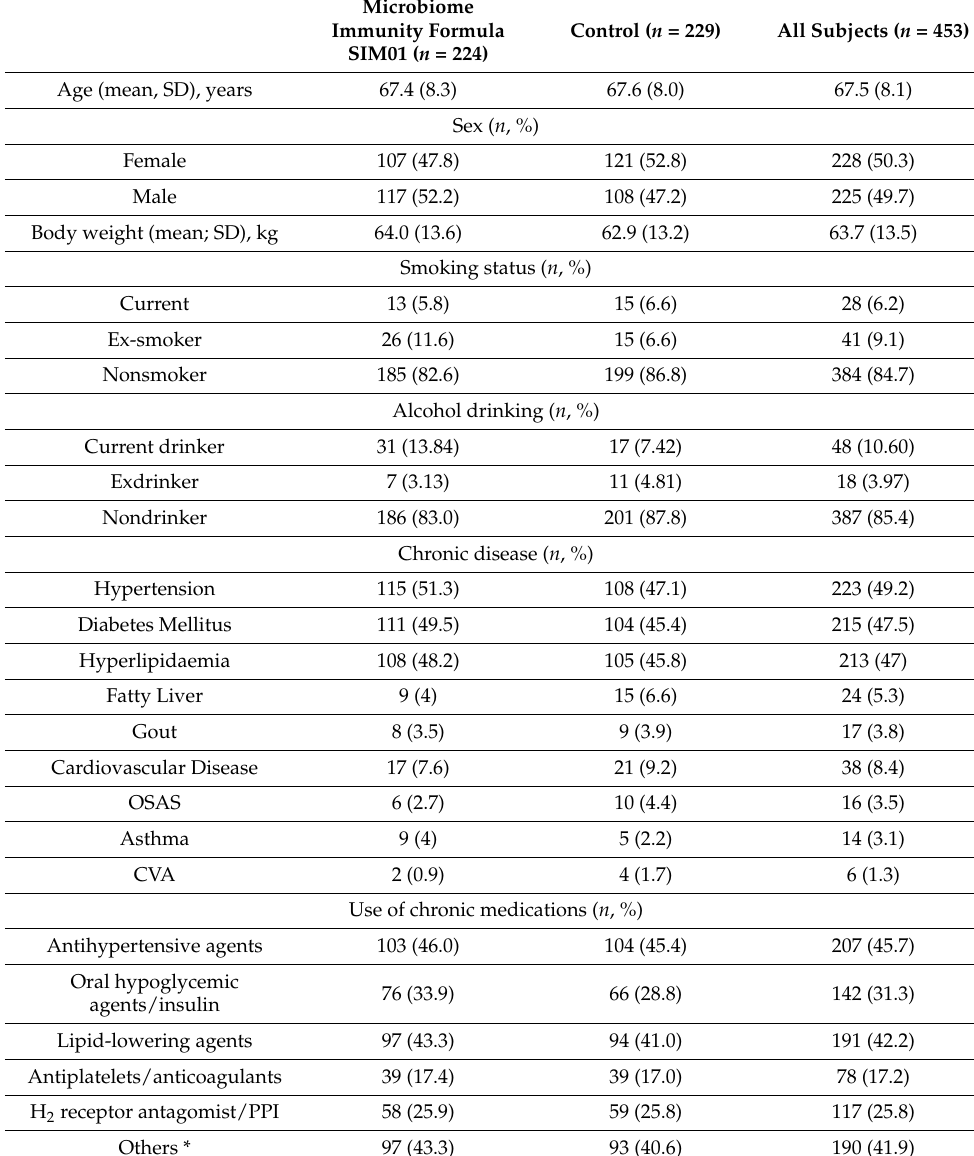
Table 1. Participant characteristics at